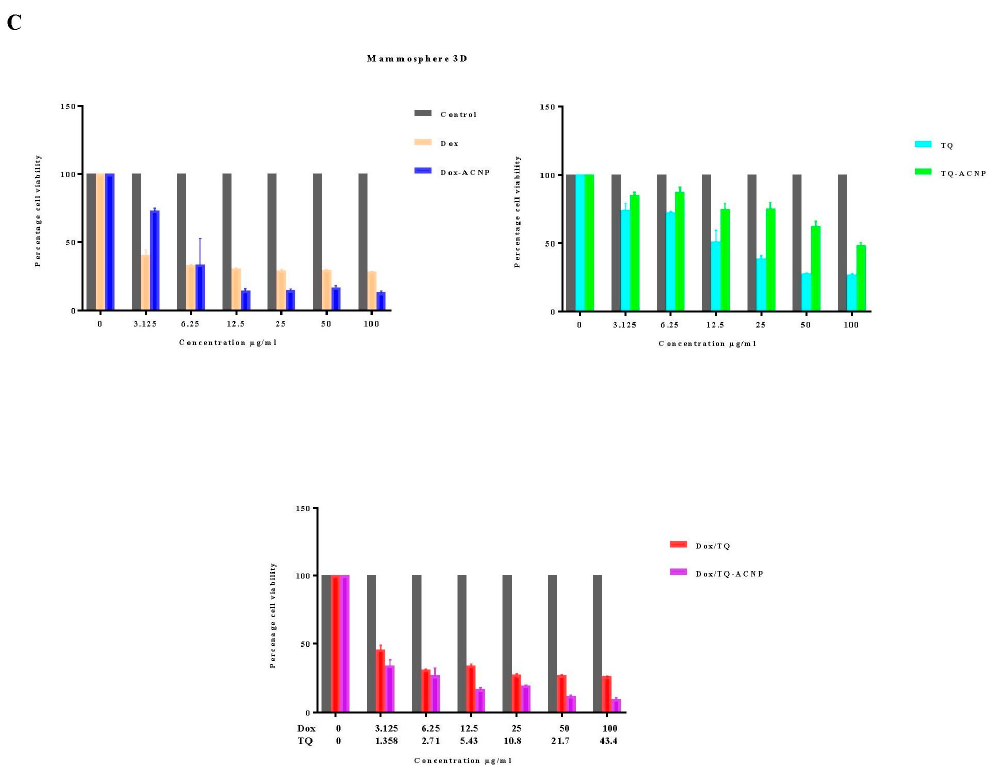
Figure 5. Graphs showing cell viability of ( A ) monolayer, ( B ) single cell 3D, and ( C ) 3D mammosphere after various treatments for 10 days.